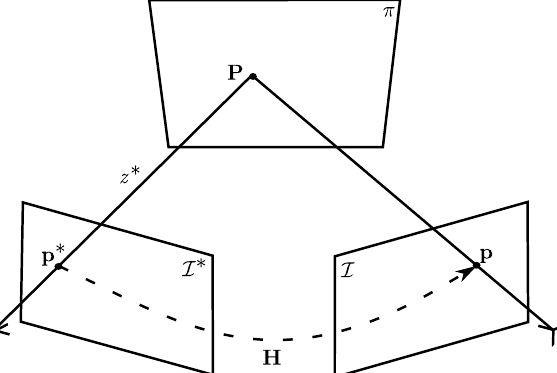
Figure 1. Homography between two images given a